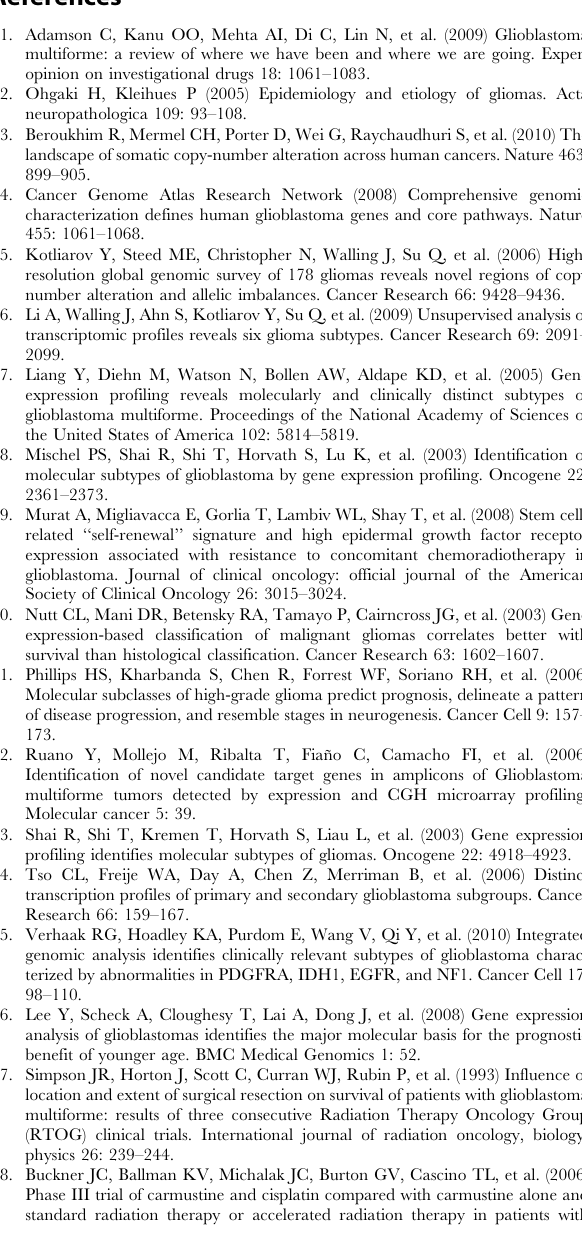
Table S13 List of genes that are (a) deleted and downregulated (b) amplified and upregulated in the old group. DAGs are computed from SNP 6 platform. DEGs are the intersection of genes found in Affymetrix U133A and Agilent G4502A platforms. Table S14 List of enriched motifs in the promoter regions of the differentially expressed genes appear in both Affymetrix U133A and Agilent G4502A platforms.